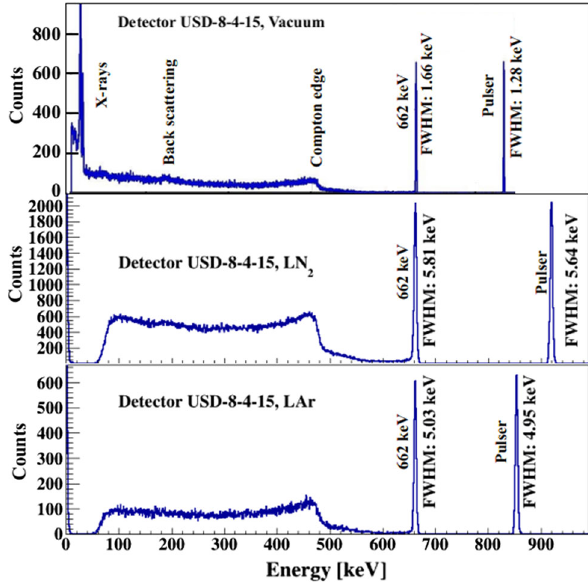
Fig. 19 Energy spectra taken with detector USD-8-4-15 in various environments